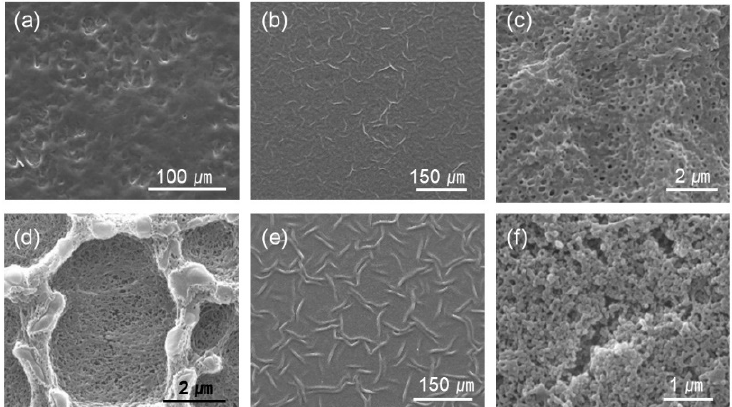
Figure 3. Selected images of different magnification from Figure 2. The PAH ratio and acid treatment pH are ( a ) PAH 0%, pH 2.4 ( b , c ) PAH 25%, pH 2.0, ( d ) PAH 100%, pH 2.0, ( e ) PAH 25%, pH 1.8, and ( f ) PAH 100%, pH 1.8, respectively.